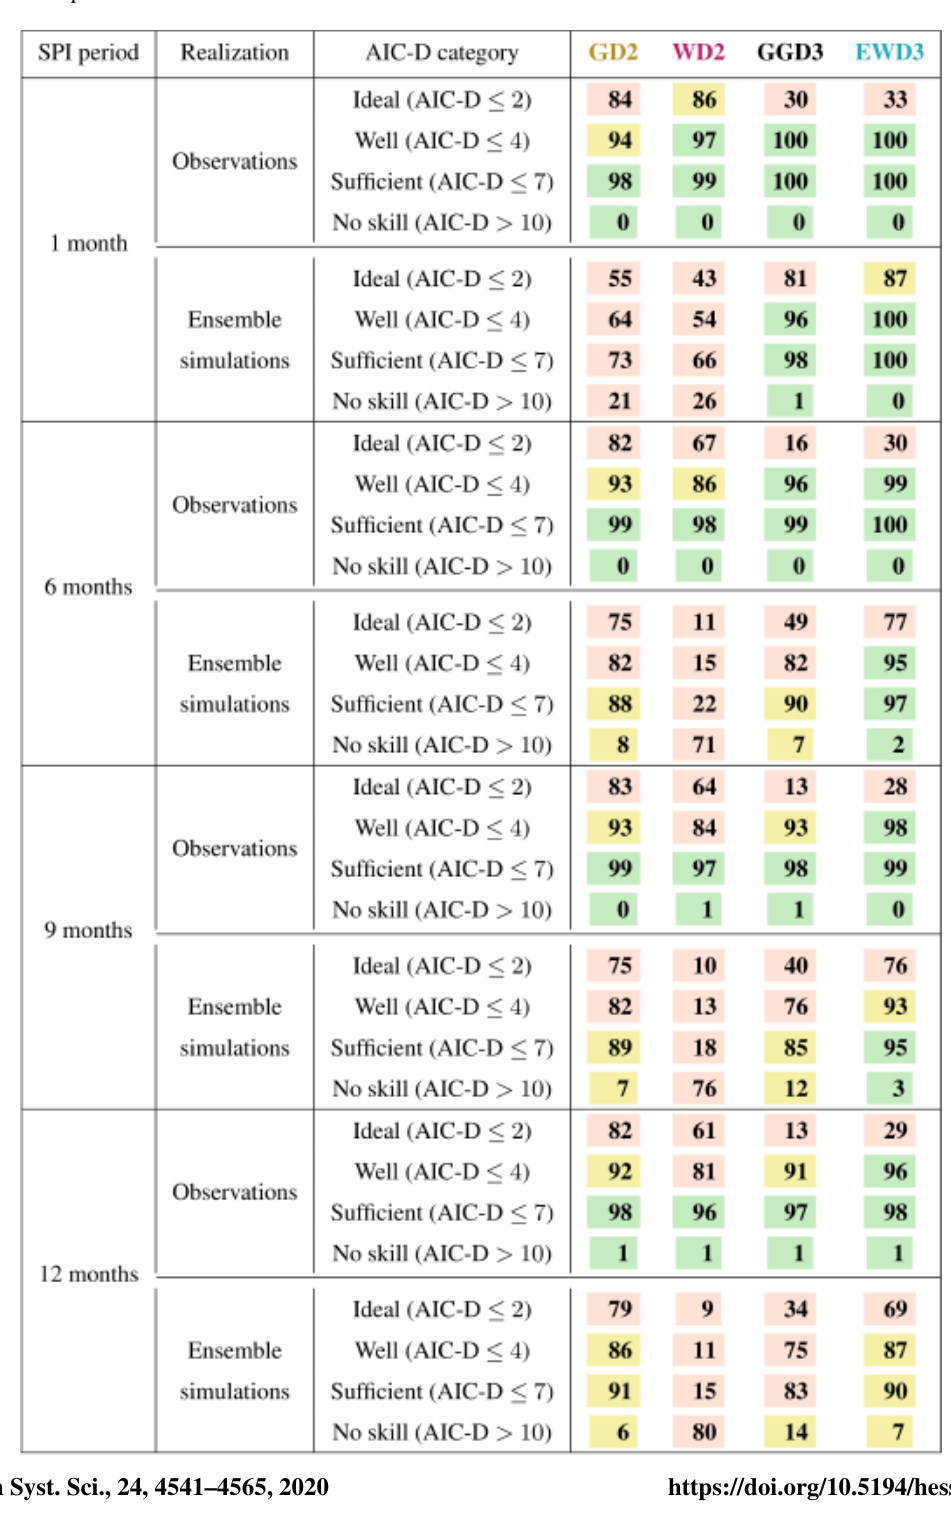
Table 6. Percent of grid points that are classified into specific AIC-D categories (according to Burnham and Anderson, 2002) for each candidate PDF over both seasons. Percentages of grid points indicate the confidence in candidate PDFs to overall performance according to the respective AIC-D category. We consider percentages that exceed (subceed in case of AIC-D values beyond 10) 95% (5%) as a sign of substantial confidence in the candidate PDF (green) to overall performance according to the respective AIC-D category. In contrast, we consider those candidate PDFs that exceed (subceed) in 85% (15%) of the grid points as a sign of average confidence in the candidate PDF (yellow) to overall performance according to the respective AIC-D category. Percentages that fall short of 85% (or that show no skill in more than 15%) are considered as an overall sign of insufficient confidence in the candidate PDF (red). In contrast to Table 3, this table evaluates different accumulations periods of